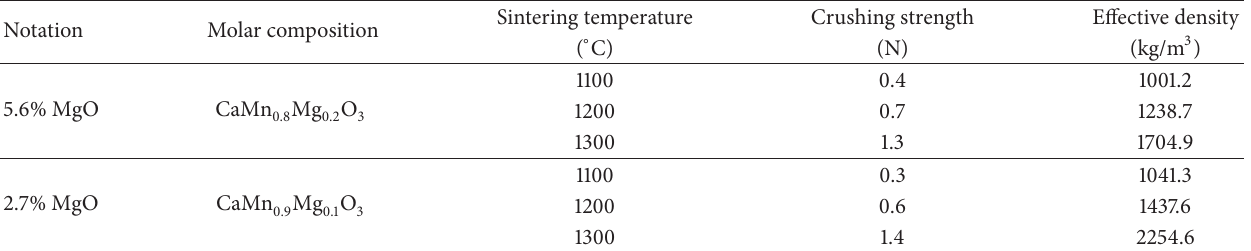
Table 5: Crushing strength and effective density of MgO added CaMnO 3−𝛿 materials .